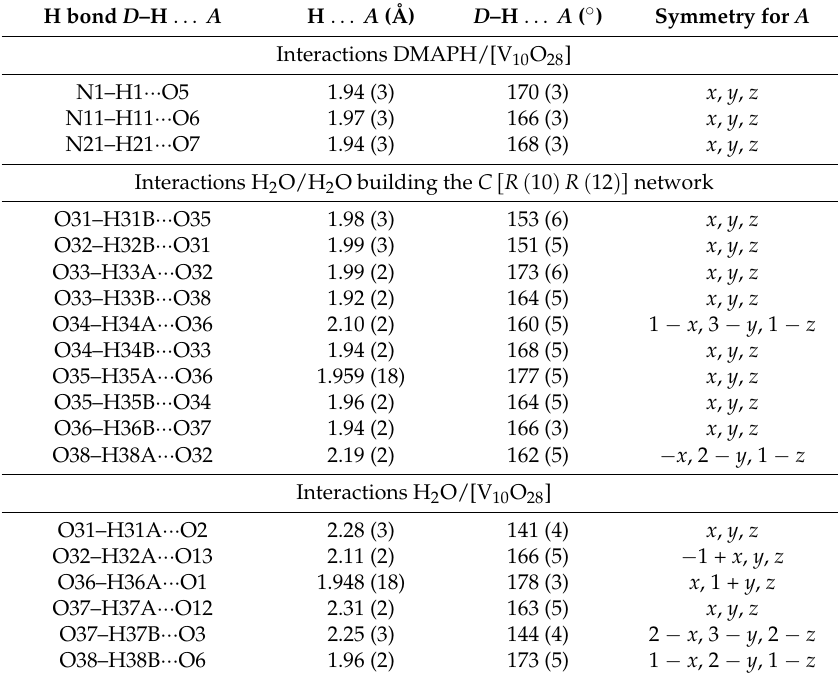
Table 2. Hydrogen bonds in the crystal structure of 2